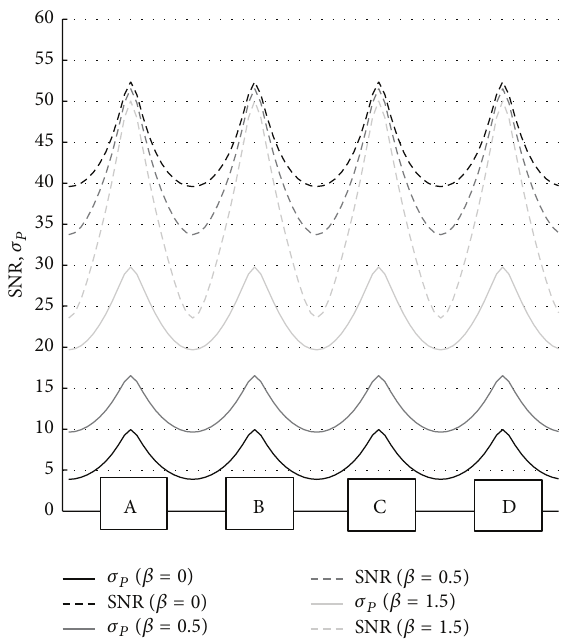
Figure 6: Behaviour of 𝜎 𝑃 and SNR in a 4-branch i-MIMO linear deployment for different values of the propagation model parameters (RAU antenna distance: 20 m).